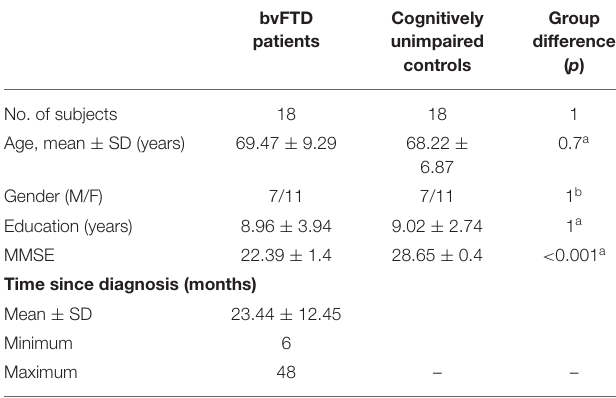
TABLE 1 | Synopsis of the final study sample characteristics. TABLE 2 | Evaluation of frailty and neuropsychological characteristics of bvFTD